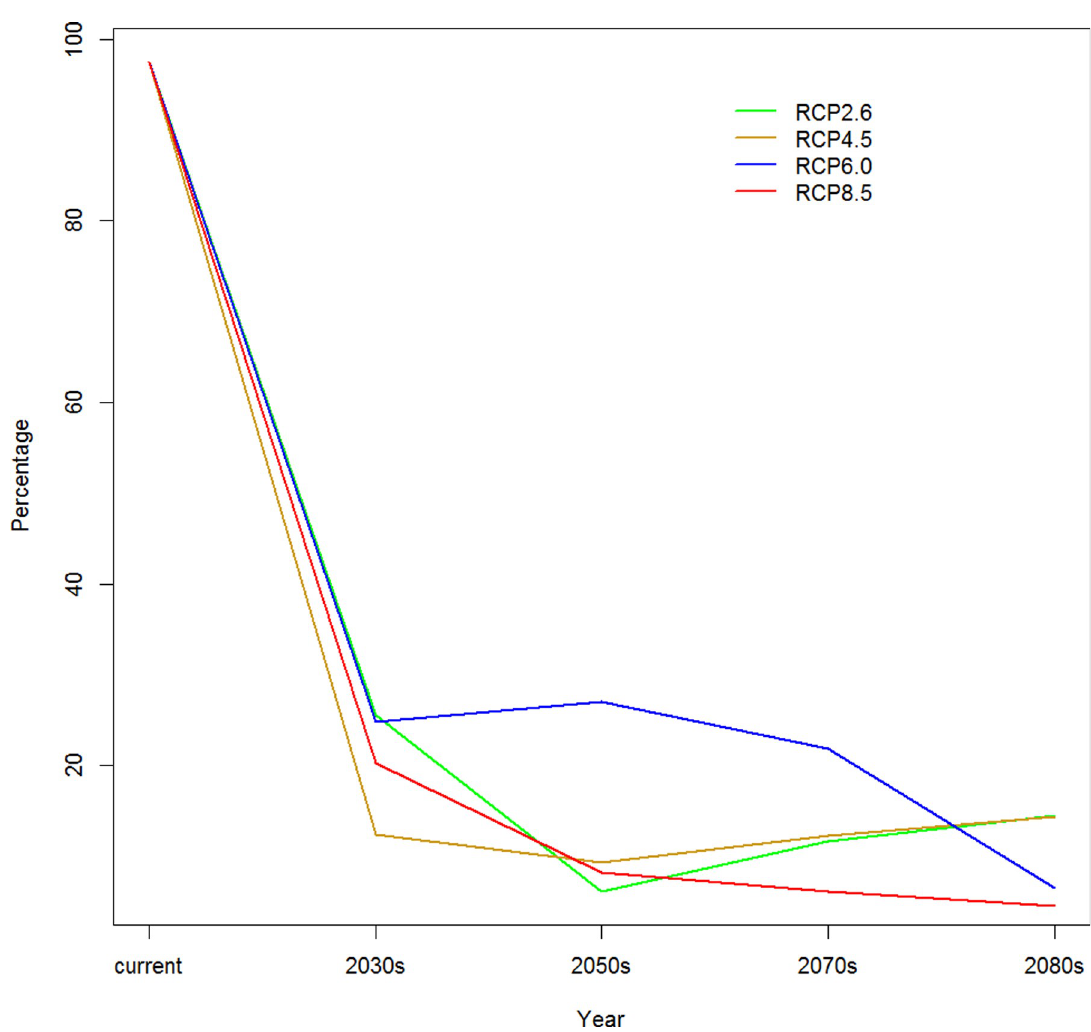
Fig 5. Proportion of grid cells predicted to be breeding area in the actual breeding range.